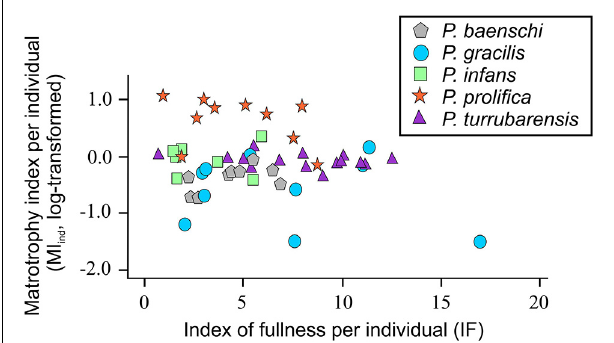
FIGURE 2 | Lack of association between the matrotrophy index per individual (MI ind ) and the individual index of fullness (IF) for 51 females of five fish species from the genus Poeciliopsis